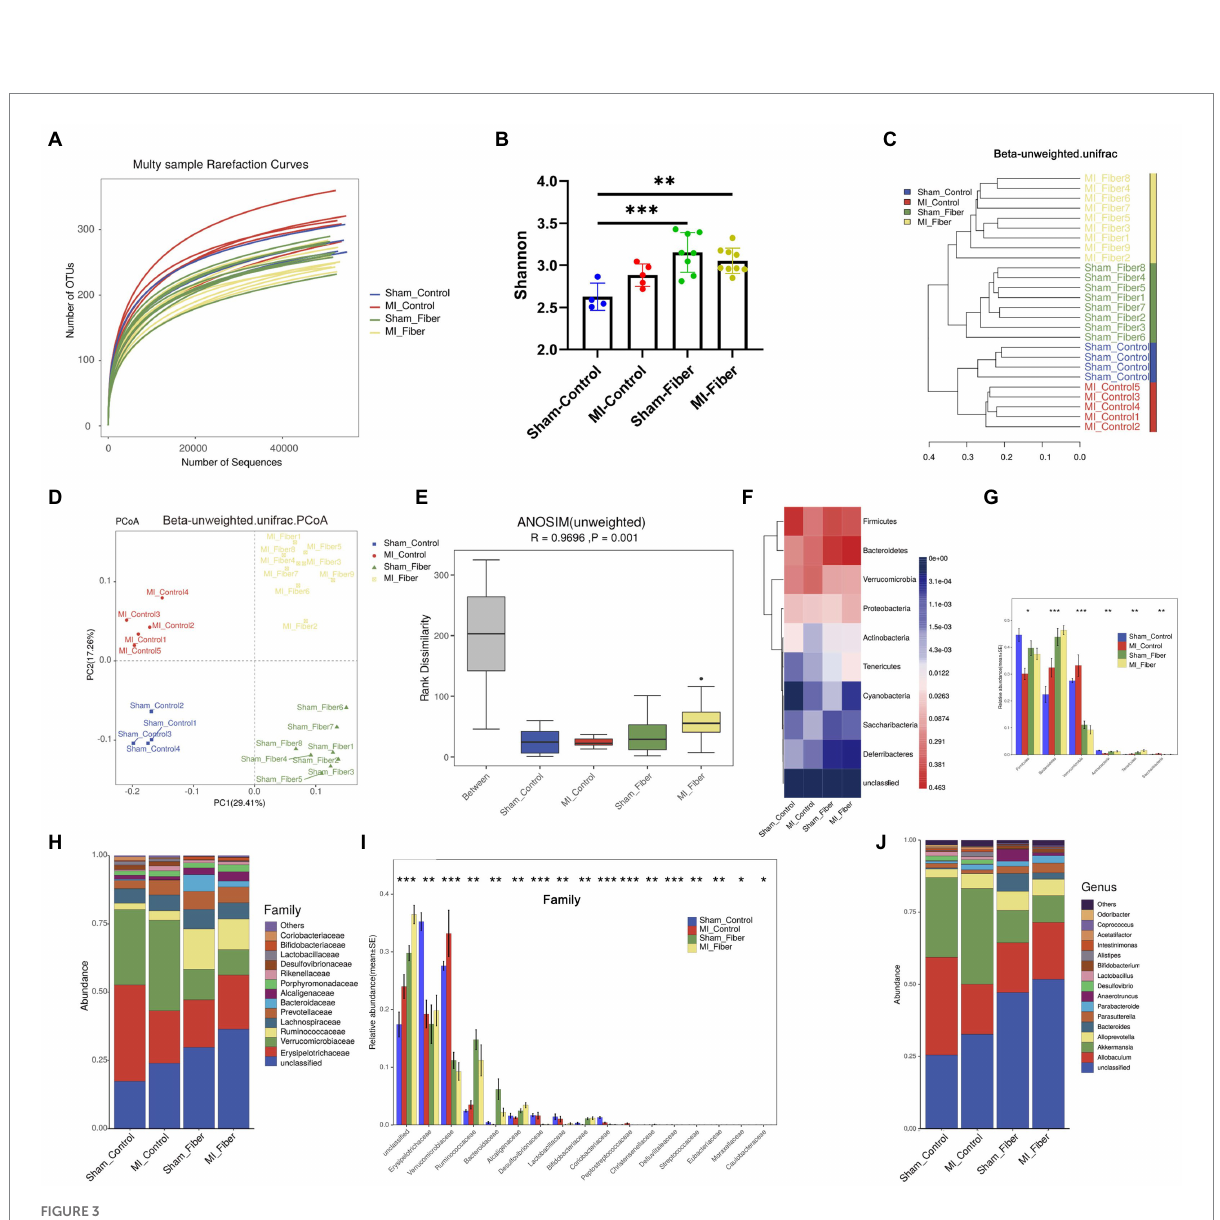
FIGURE 3 High fiber diet alters the composition of the gut microbial community. (A) Rarefaction curves of each sample. (B) Bacterial α -diversity estimated by Shannon’s diversity among groups. (C) Samples’ clustering result (Description, Beta unweighted_unifrac). (D) Bacterial β -diversity of principal coordinates analysis (PCoA) based on unweighted_unifrac distance indicated a distinctive distribution of the colonic microbial communities among all groups. (E) Anosim similarity analysis based on unweighted_unifrac distance rarefaction curves of each sample. (F) Heat map depicting gut microbial composition at phylum level. (G) Relative abundance of significantly different taxa at phylum level. (H , I) Proportion and relative abundance of different taxa at family level. (J) Proportion of different taxa at genus level. Sham control, n = 4; Sham fiber, n = 8; MI control, n = 5; MI fiber, n = 9. * p < 0.05, ** p < 0.01, *** p < 0.001, **** p <